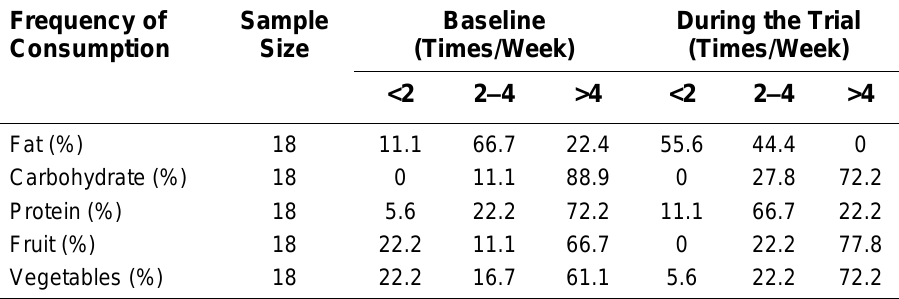
Weekly Diet of the H. persicum Group at Baseline and During the